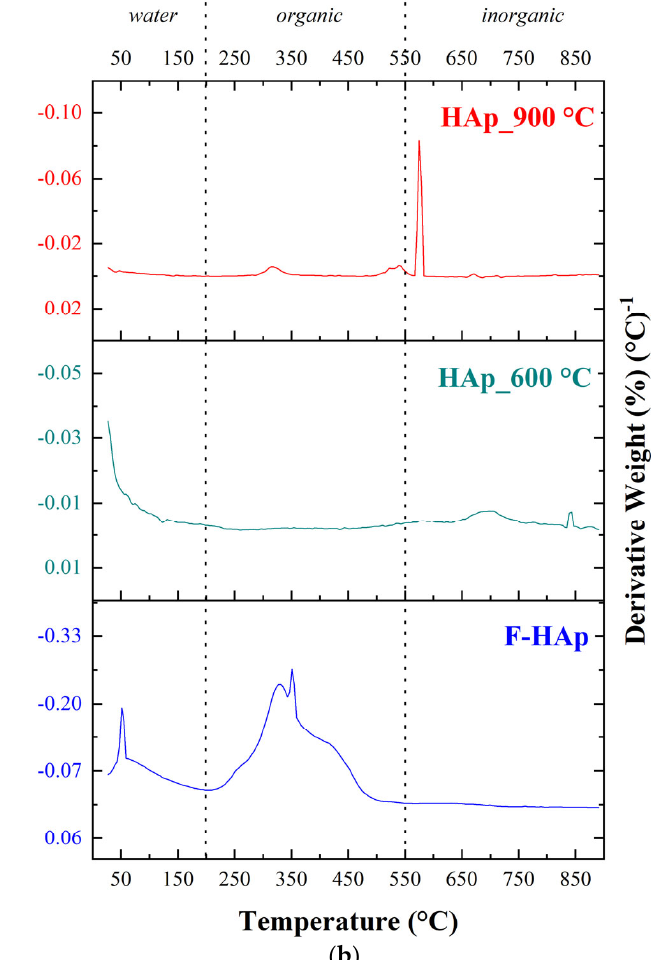
Figure 5. ( a ) Thermogravimetric Analysis (TG) of F − HAp, HAp_ 600 °C and HAp_900 °C and their ( b ) first derivative curves (dTG).